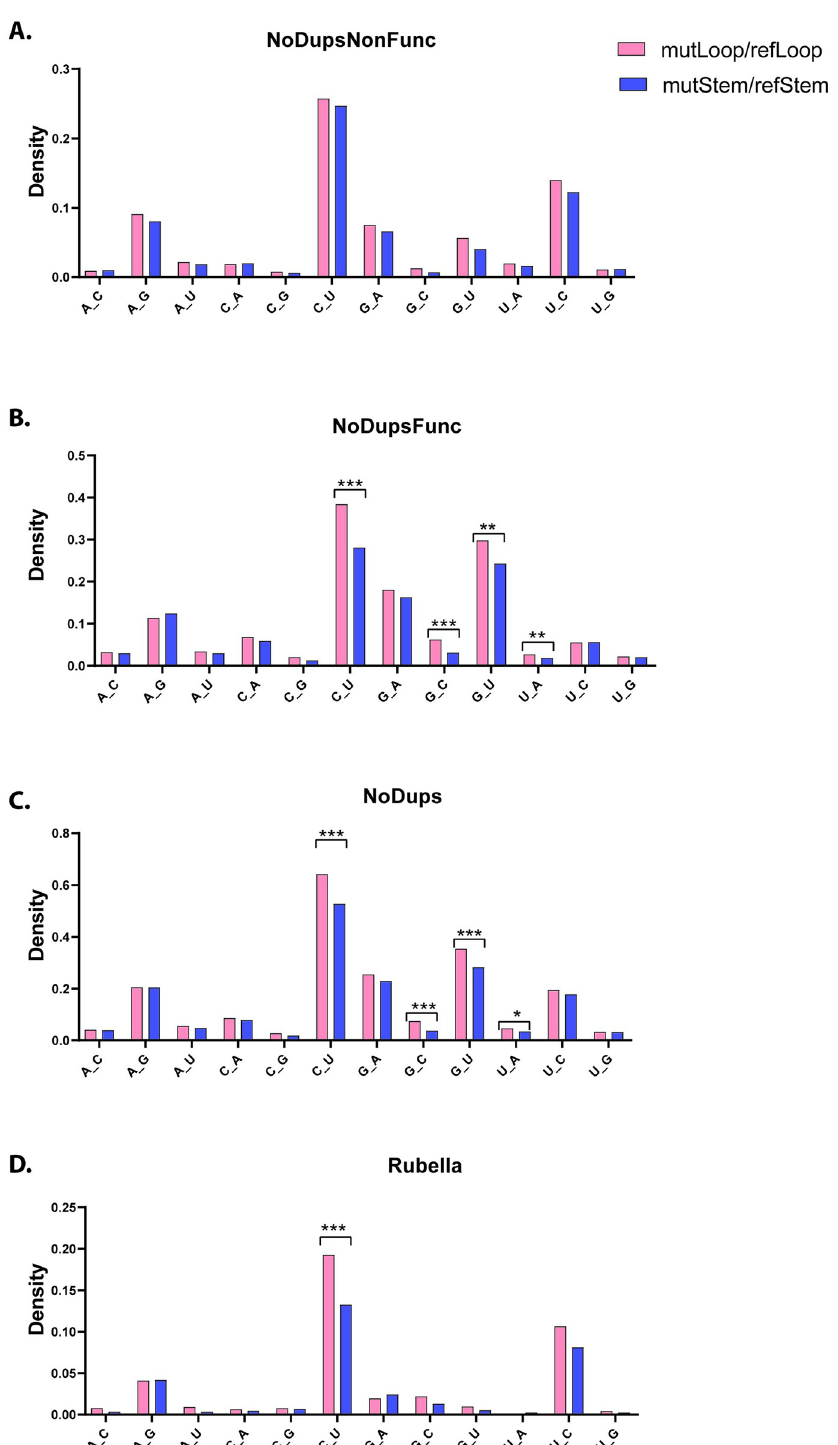
Fig 3. Comparison of base substitution mutagenesis between locations prone to loop or stem formation in viral RNA genomes. Creation of filtered SARS-CoV-2 MAFs and their abbreviated names NoDupsNonFunc, NoDupsFunc, NoDups, are described in Fig 1 and in associated text. Bars represent densities of base substitutions in stem- or in loop- forming sections. Densities are calculated by dividing counts of each base substitution in either loop or in stem by counts of the substituted base in the loop-forming or in stem-forming regions of the reference sequence.